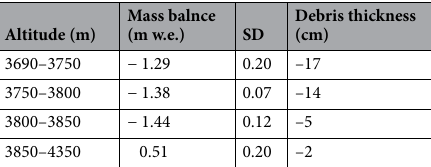
Table 3. Altitudinal variation of mass balance of the Hoksar